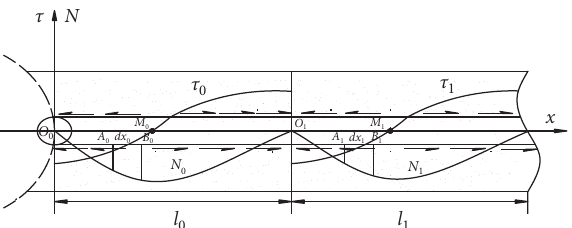
Figure 10: Mechanical model of neutral point on anchor bolt